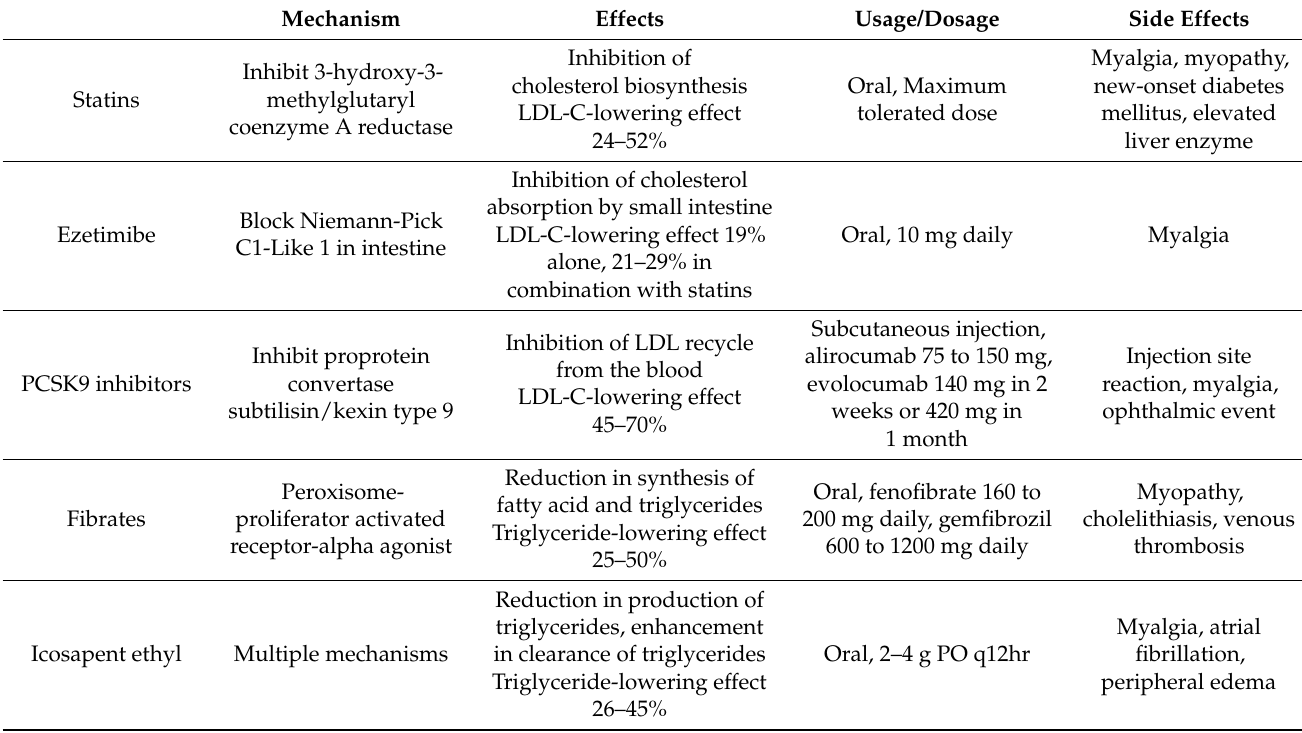
Table 1. Characteristics of lipid-lowering agents for prevention of